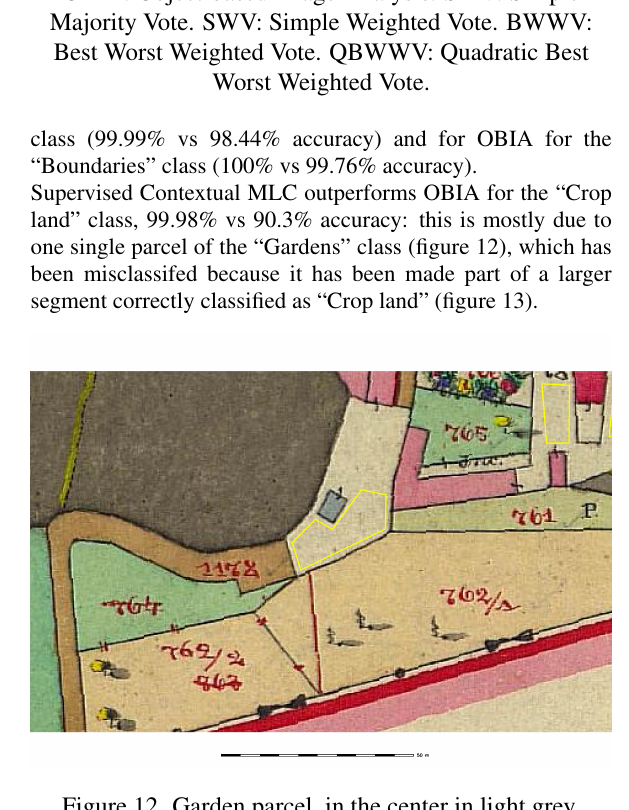
Figure 12. Garden parcel, in the center in light grey, containing a darker grey rectangle, which is misclassified.